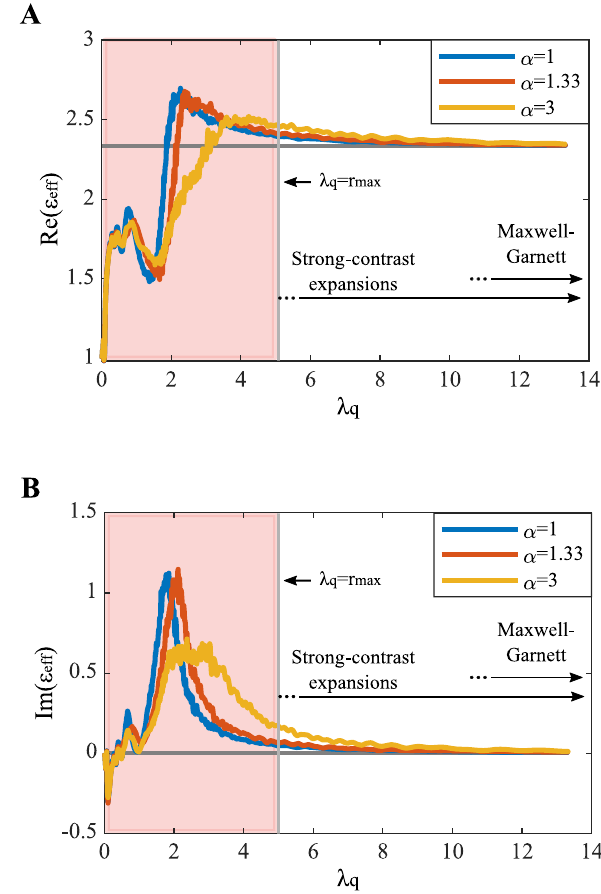
Figure4: Thecomplexeffectivedielectricconstant ( ε eff ) forjammed rectangular nanostructures calculated by the strong contrast expansionmethodandplotted as a functionof wavelength ( λ q ) . The 2Drectangleshavewidth w =1,height h (cid:2) α ,permittivity ε p (cid:2) 9,and ) in a background medium with are maximally packed ( ϕ max permittivity ϵ q (cid:2) 1 . (A) The real part of ε eff showing an explicit redshift as α increases, and (B) the imaginary part of ε eff showing largerscatteringas α increasesfor λ q ≫ r max .Inthelongwavelength limit, both the real and imaginary parts of ε eff approach the Maxwell – Garnett